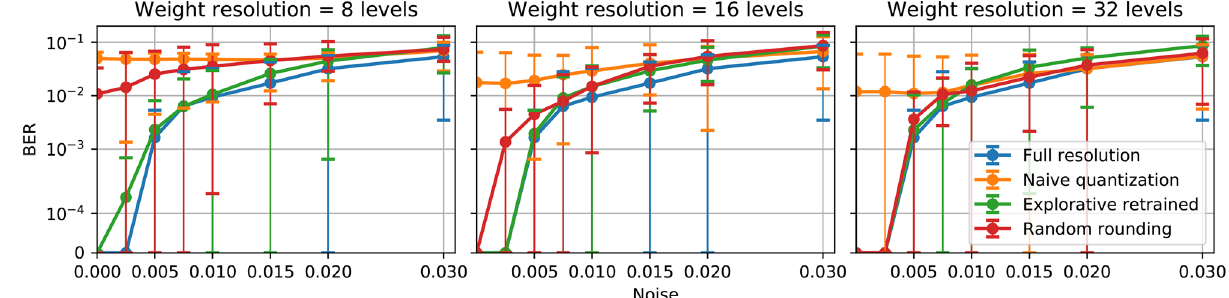
Figure 3. Performance comparison of three different weighting resolutions, 8 levels (left), 16 levels (middle), 32 levels (right) for the 4-bit header recognition task over different noise levels. The blue curve represents the performance of full-resolution weights; the orange curve represents ‘naive’ quantization weights; the green curve for explorative retrained quantization weights.